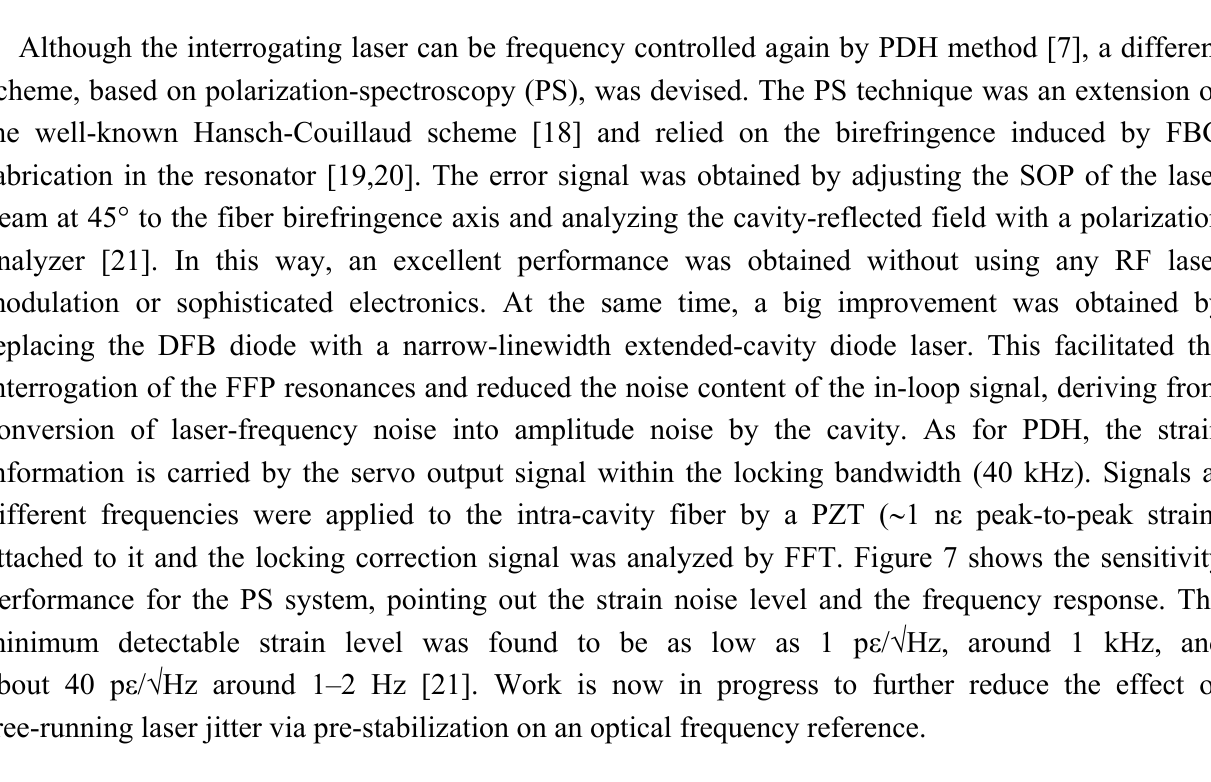
Figure 8. Pound-Drever-Hall interrogation set-up of the HiBi FBG cavity. PD: photodiode; DBM: double-balanced mixer; LF: low-frequency; HF VCO: high-frequency voltage-controlled oscillator; PBS: polarizing cube